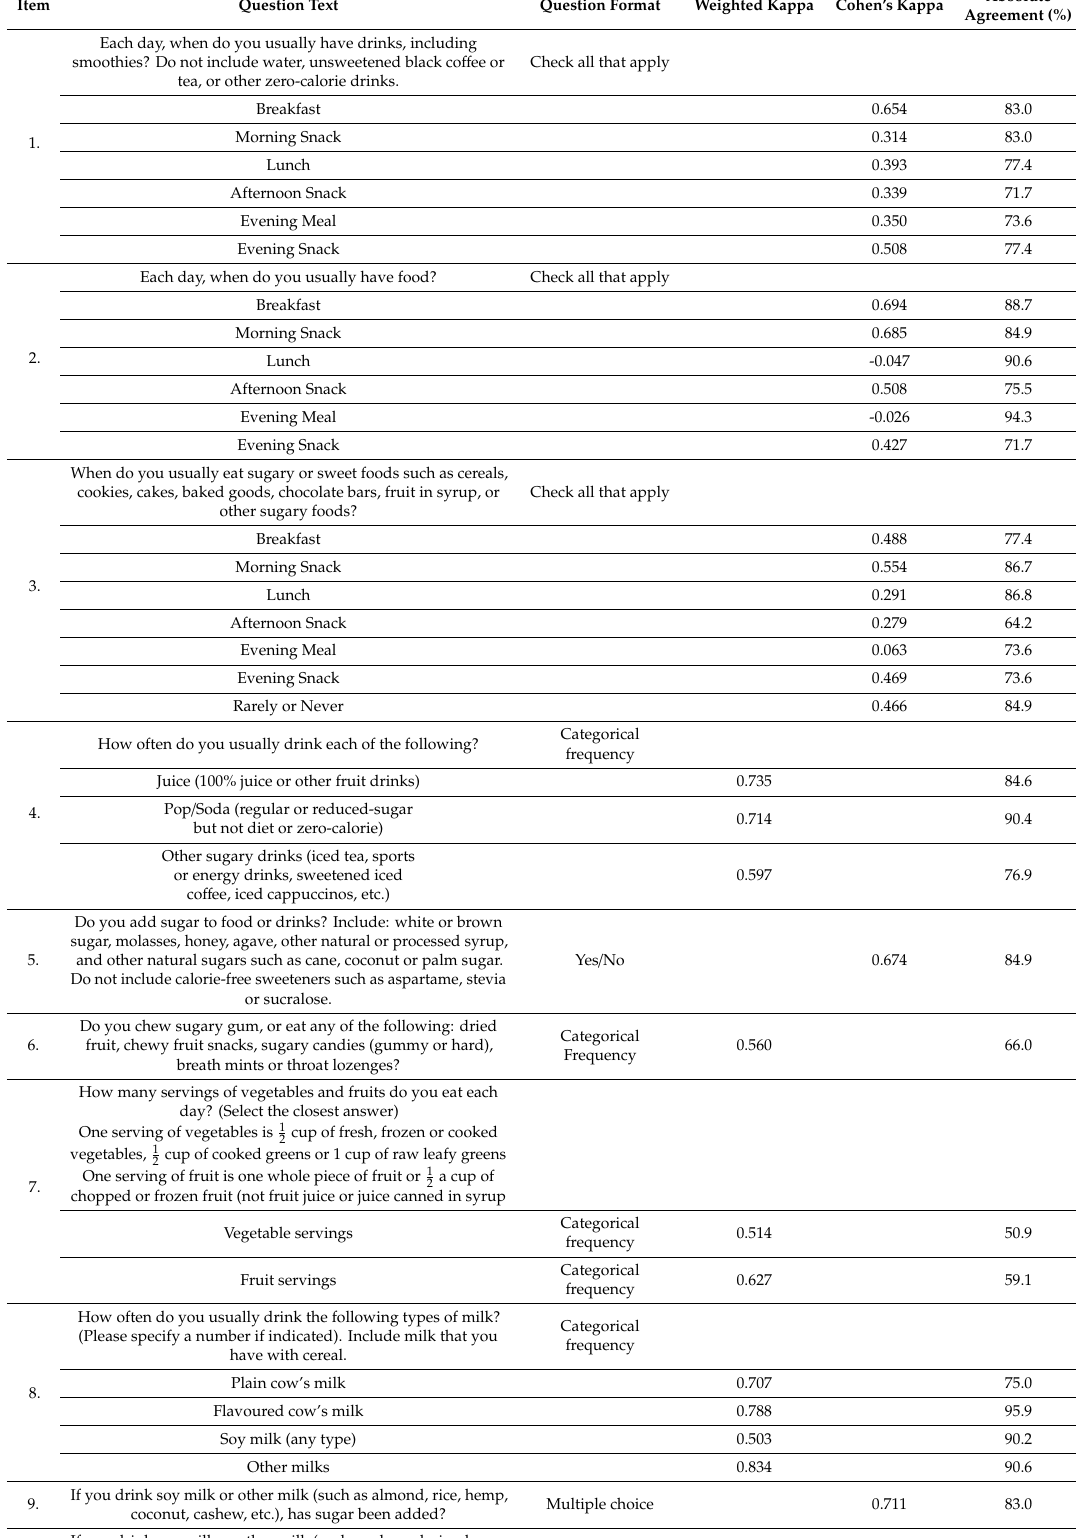
Table 4. Nutrition Questionnaire Test-Retest Reliability